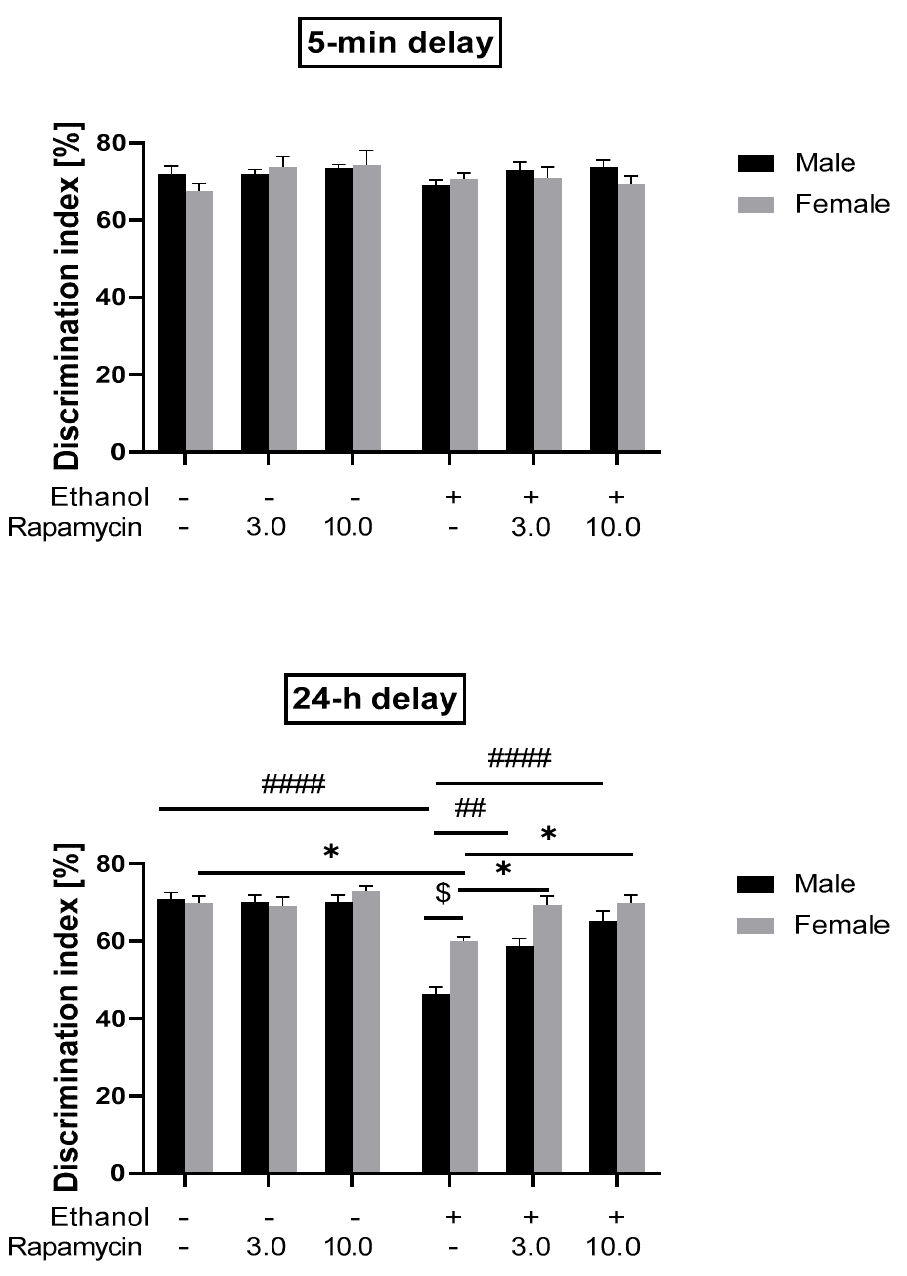
Figure 3. The influence of rapamycin pre-treatment (3 and 10 mg/kg, i.p.) during ethanol admin- istration (postnatal day (PND) 4-9) on short- and long-term memory deficits in the novel object recognition (NOR) test (expressed as discrimination index) in adult (PND 59-60) rats. Results are expressed as mean ± SEM of 8 subjects per group. * p < 0.05 vs. Control; ## p < 0.01, #### p < 0.001 vs. EtOH; $ p < 0.05 vs. EtOH.